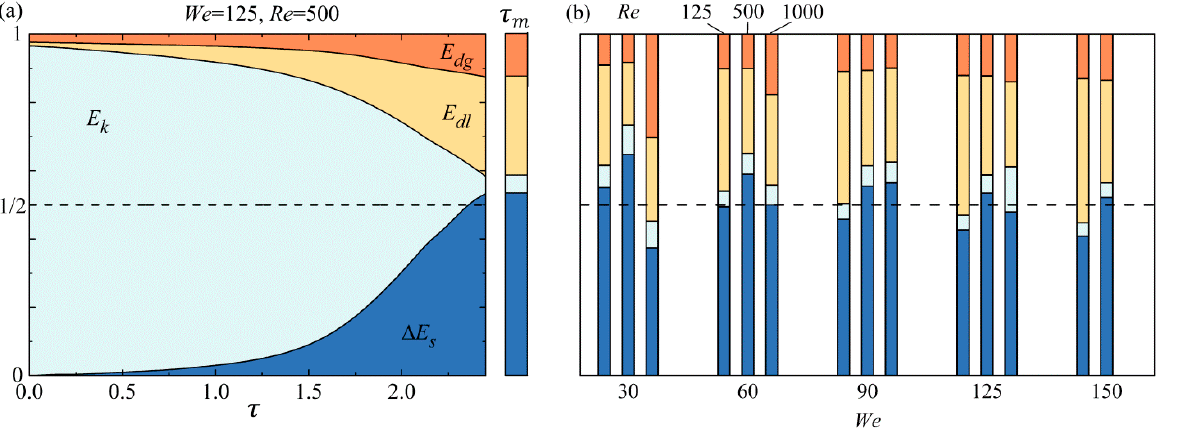
Figure 6. Energy budget of droplet spread on the free-slip surface under We ≥ 30. The dash line indicates the “1/2 rule”. ( a ) the evolution of four different energies during droplet spreading process and ( b ) shows the energy budget at τ max for various droplet inertias and Reynolds numbers.